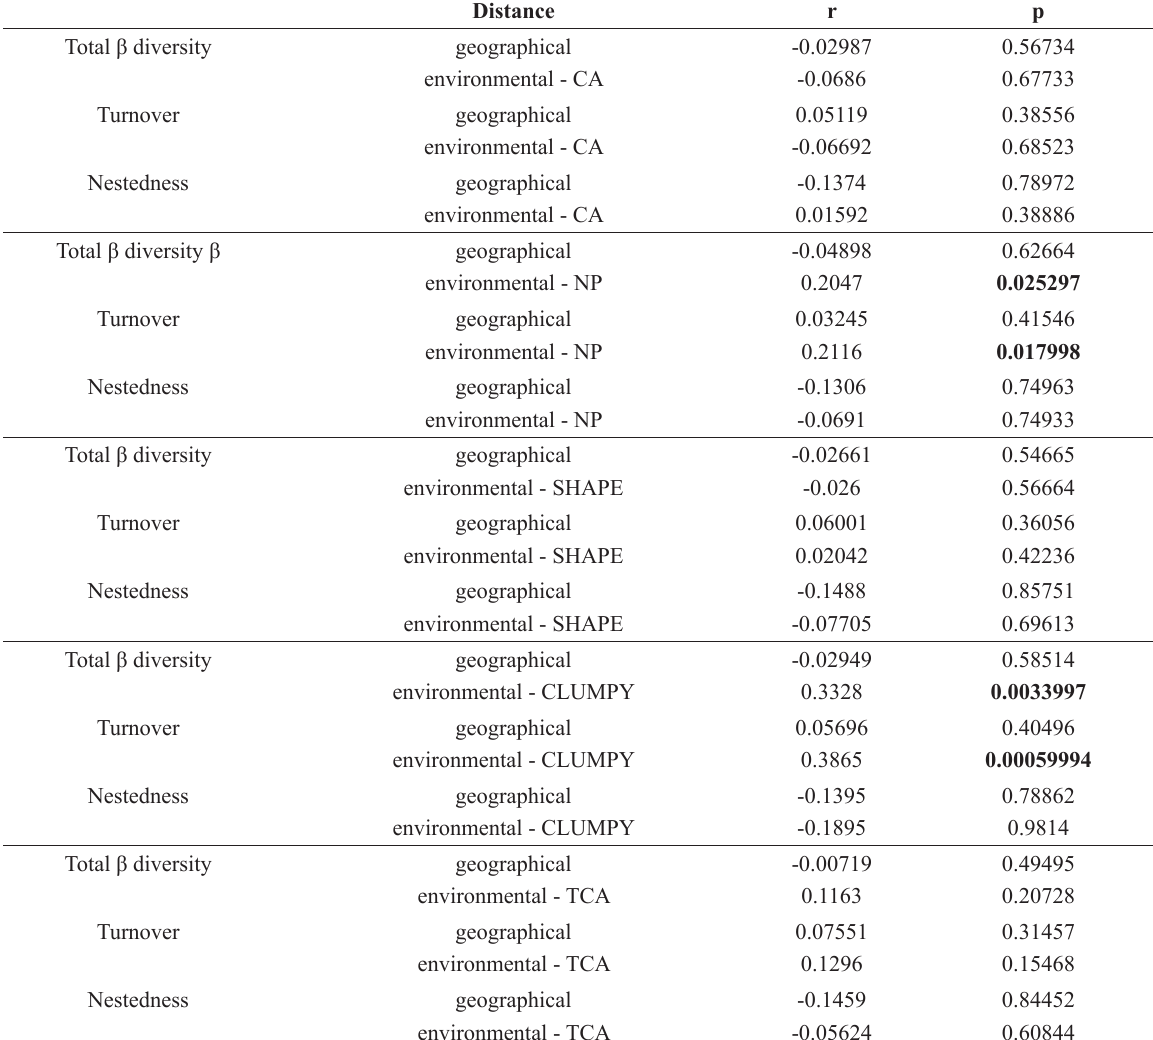
Partial Mantel test values (r = the correlation coefficient; p = level of significance) considering the geographical and environmental distances of the surrounding landscapes of the 17 forest